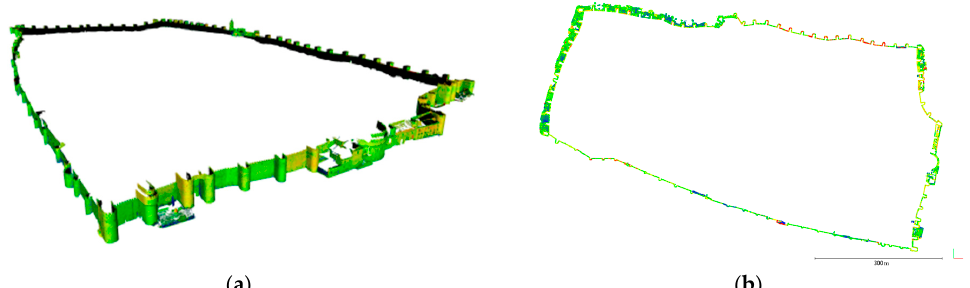
Figure 4. TLS 3D point cloud ( a ); and XY view ( b ) of the Wall of Avila.